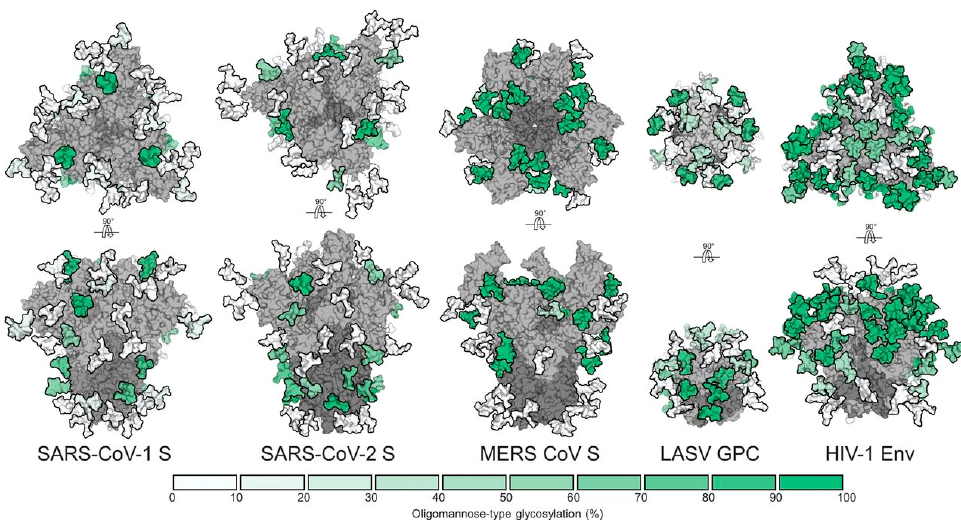
Figure 1. Glycan shields from different viruses. The number of glycans in SARS-CoV-2 is lower compared with the other viruses. This image is reproduced from an open-access article distributed under the terms of the Creative Commons CC BY license, which permits unrestricted use, distribution, and reproduction in any medium, provided the original work is properly cited. Source: